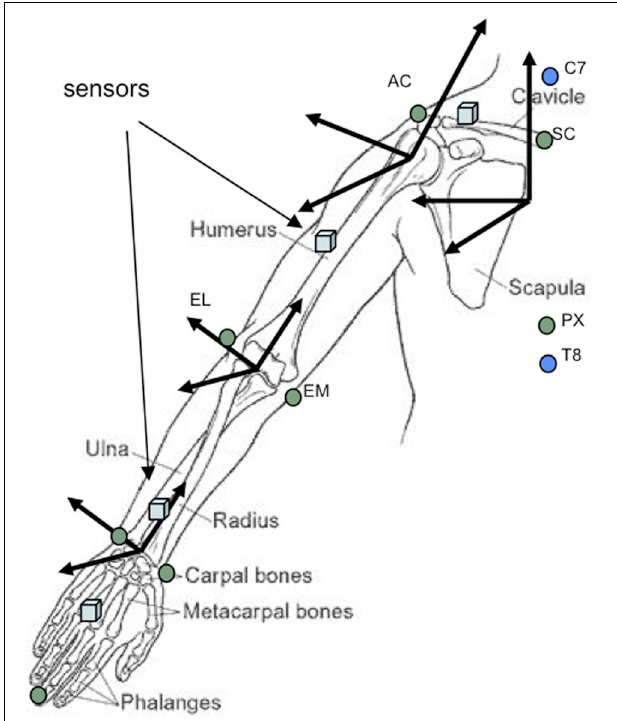
FIGURE 5 | Location of upper limb movement sensors and calculation of joints using the CAST method (calibrated anatomical system technique). Rectangular blue markers correspond to the approximate placement of movement sensors whilst circles indicate anatomical landmarks recorded using the stylus of the spatial tracking